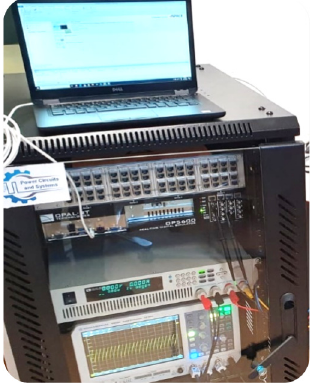
Figure 7. The Real-time setup of the SEFPC based on OPAL-RT.